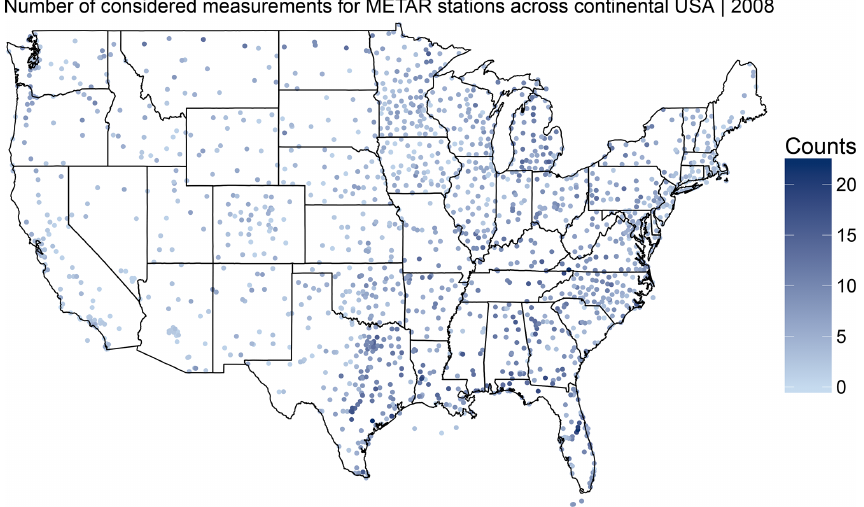
Figure 2. Locations of ceilometer stations utilized in this study across the continental USA. Data from these stations for the years 2008 and 2007 are used for the calibration of the z base retrieval algorithm and a subsequent evaluation, respectively. Blue shading indicates the number of valid coincidental retrievals from MISR and ceilometers which were utilized for the calibration (year 2008) and are within the constraints described in the